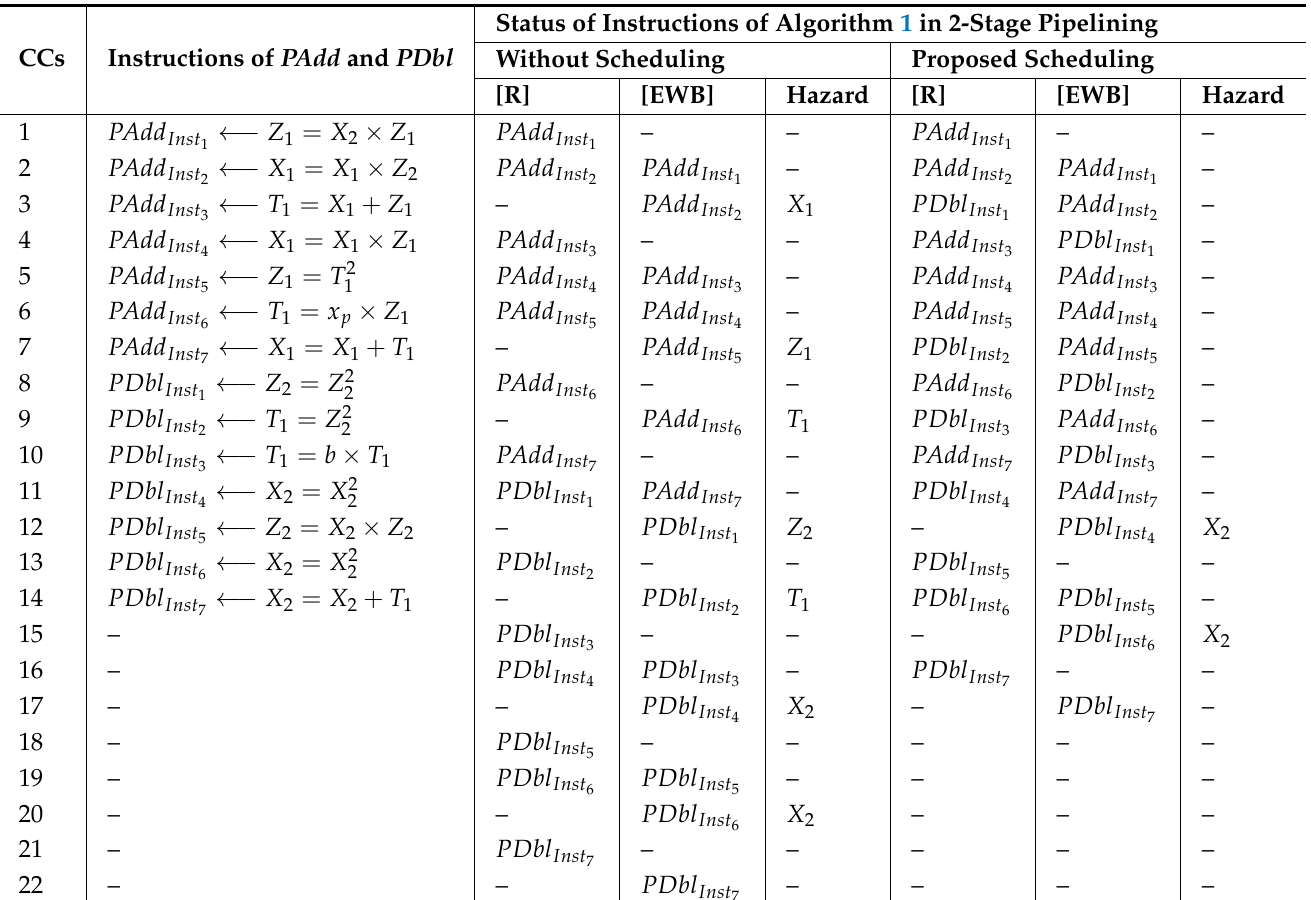
Table 1. Status of instructions of PAdd and PDbl functions of Algorithm 1 in a two-stage